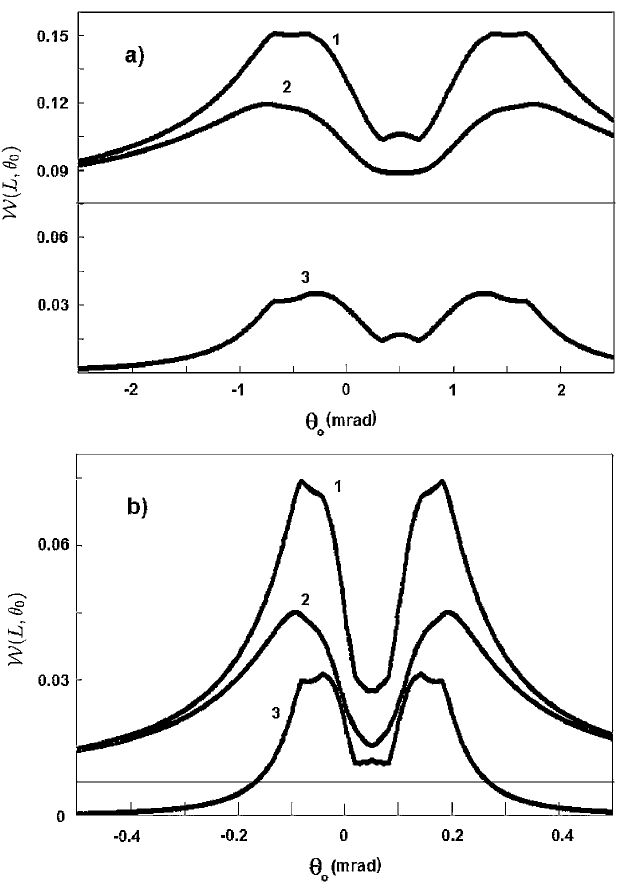
FIG. 3. Spectral distributions of the electrons (positrons) pro- duced in a single bent silicon crystal at the conditions of Fig. 2, for the two cases (a) and (b). The entrance angle is (cid:4) 0 ¼ þ 1 : 5 mrad (a) and þ 0 : 2 mrad (b). The numbers near the curves indicate the probabilities as in Fig. 2. The black point curves are the ones for nonoriented single